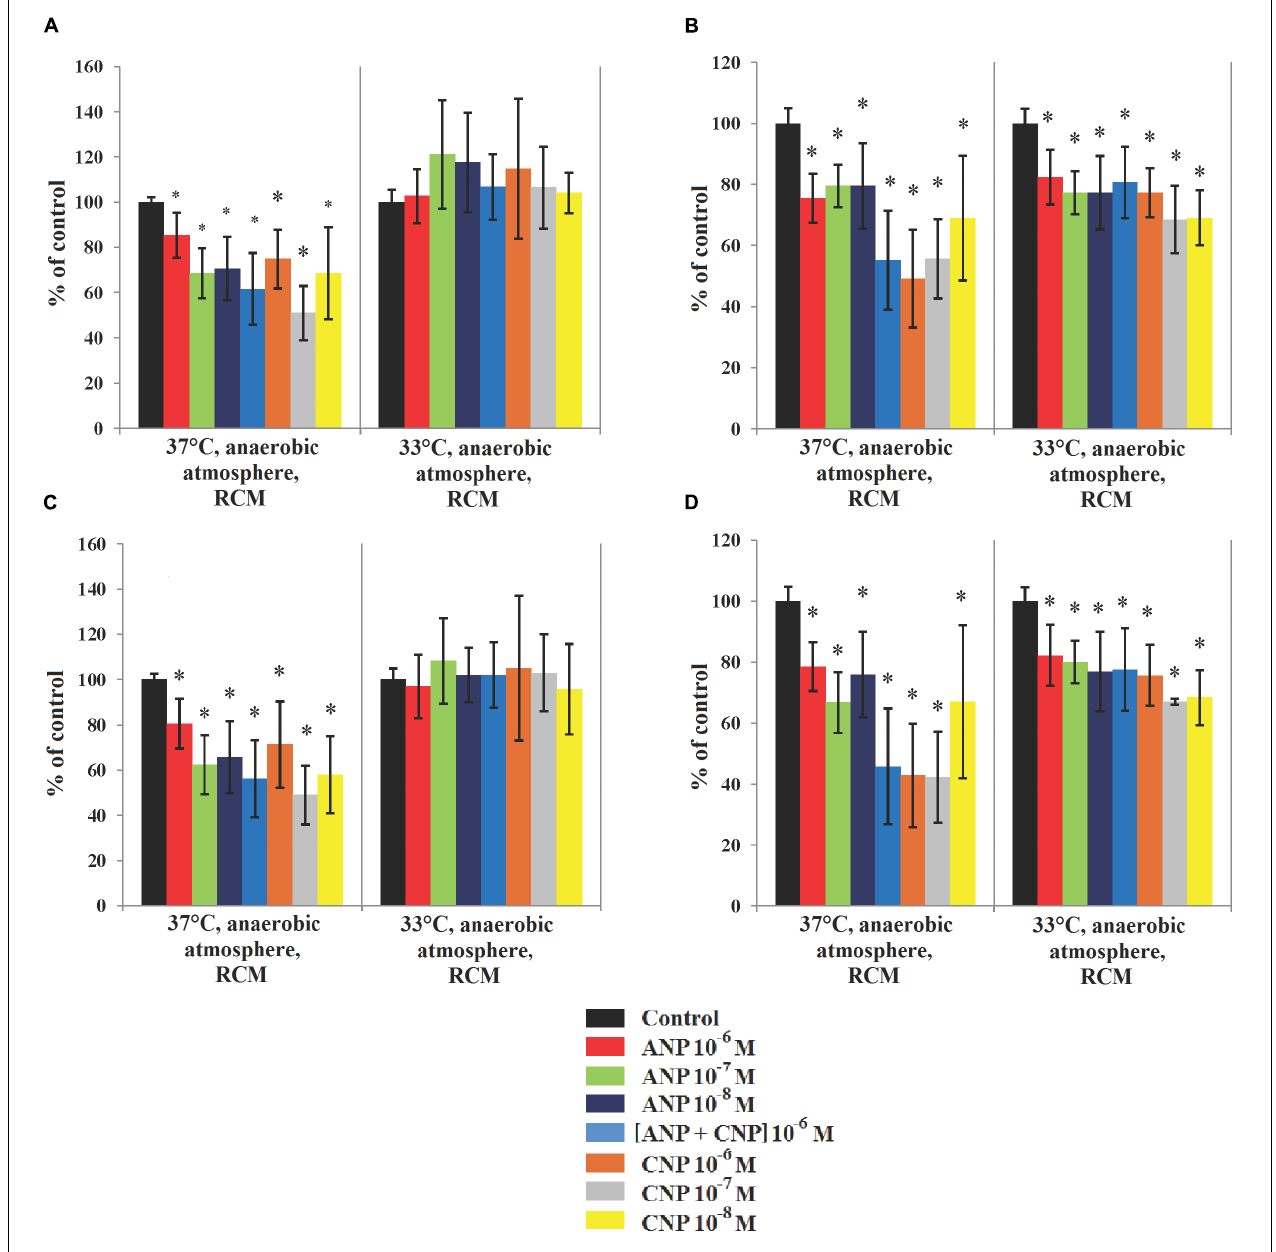
FIGURE 4 | Parameters of monospecies biofilms of C. acnes measured by CLSM in different cultivation conditions. (A) Average C. acnes RT4 biofilm biomass density; (B) Average C. acnes RT5 biofilm biomass density; (C) Average C. acnes RT4 biofilm thickness; (D) Average C. acnes RT5 biofilm thickness. ∗ P < 0.05.